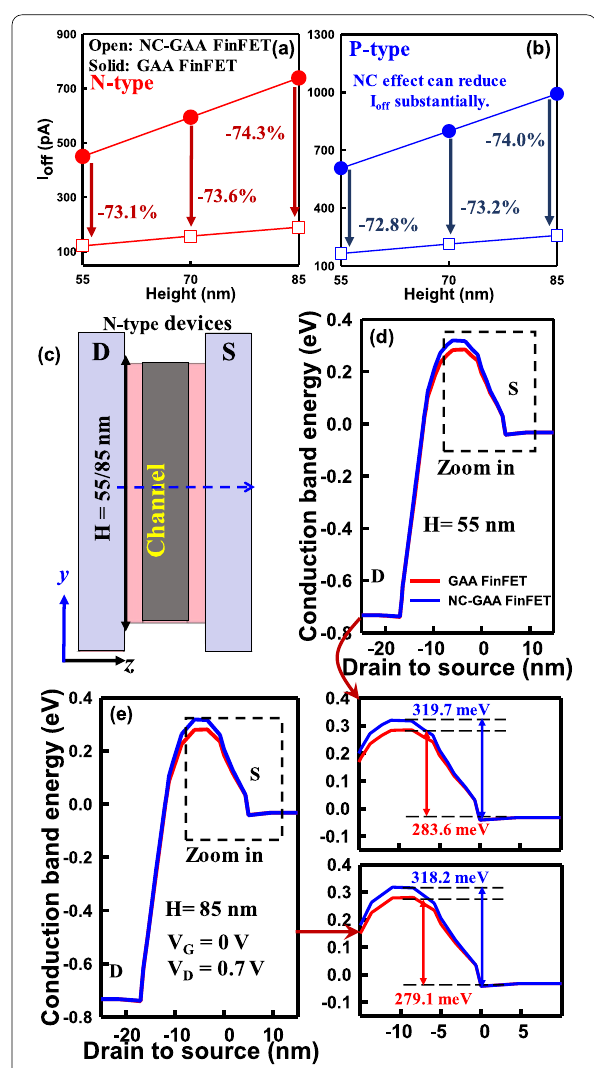
Fig. 6 The comparison of I off for a N‑/, b P‑type GAA and NC‑GAA FinFETs. As the fin height increases, I off of GAA FinFETs is enhanced. NC‑GAA FinFETs improve I off significantly. c The schematic plot of N‑type devices which extracts the conduction band energy from D to S as the blue‑dashed line. The off‑state band diagram of N‑type GAA and NC‑GAA FinFETs with the fin heights of d 55 and e 85 nm. Compared with the GAA FinFET, the off‑state band diagram of the NC‑GAA FinFET shows the higher energy barrier than that of the GAA